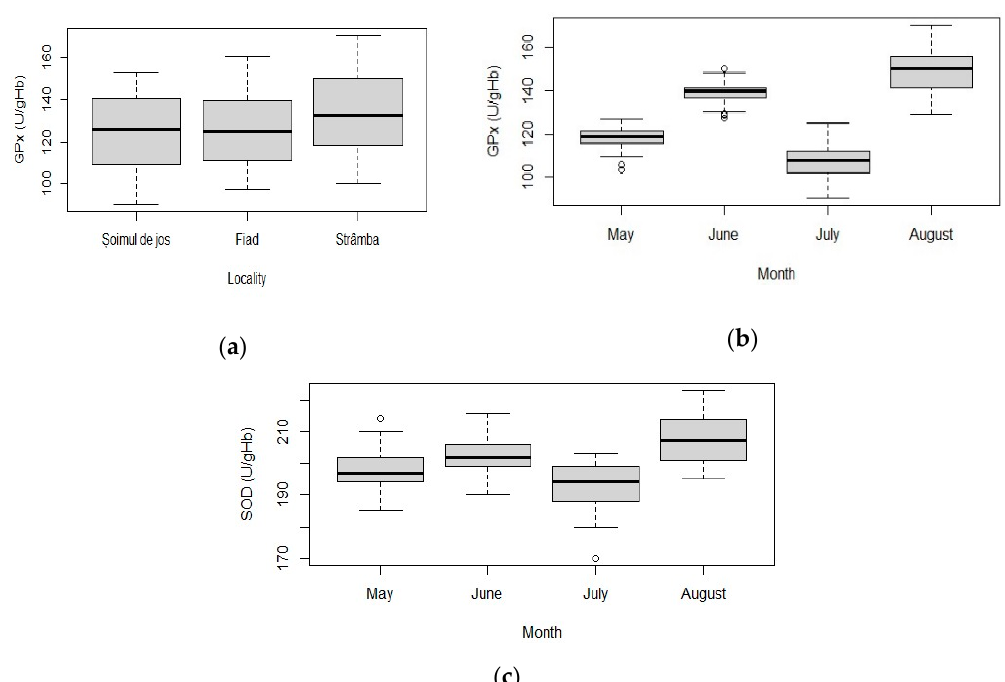
Figure 4. Antioxidant enzymes of rainbow trout ( Oncorhynchus mykiss ): ( a ) GPx values measured in all months in different farms; ( b ) GPx values in all farms in different months; ( c ) SOD values in all farms in different months. Plots represent median (line inside boxes) values, 25–75 percent quartiles (boxes), and minimal and maximal values, shown with short horizontal lines (“whiskers”). Outliers are represented with an open circle sign.